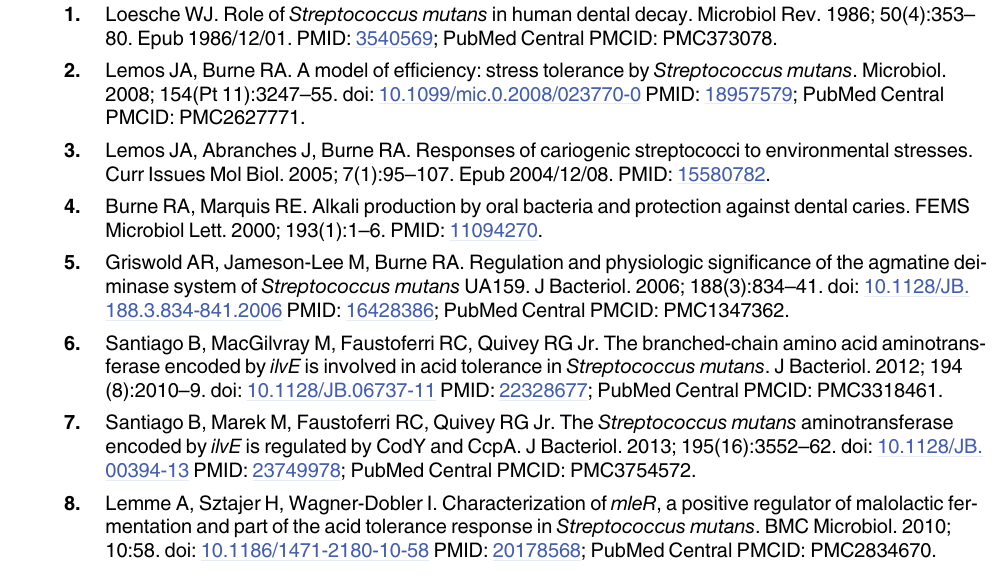
S2 Fig. The impact of growth pH and carbohydrate concentrations on the expression of the GlnR regulon genes in S . mutans GS5. Wild-type GS5 was grown in chemostat in TY contain- ing 20 mM (I) or 100 mM glucose (II) at pH 7.2 or pH 5.5. The relative quantity of mRNA of the GlnR regulon gene was measured by qPCR. The change in Δ Cq of each sample was normal- ized with 16S RNA. The Δ Cq of wild-type GS5 grown at pH 7.2 with 20 mM glucose was used as the reference. Numbers are the means and standard deviations of three independent experi- ments. The significant difference between samples under each growth condition was deter- mined by Student ’ s t test. (cid:1)(cid:1) , P < 0.001; (cid:1) , P < 0.01, #, P < 0.05. S3 Fig. The expression of dnaA , dnaE , and gyrA is not regulated by PmrA. Total cellular RNA was isolated from wild-type GS5 and strain Δ PmrA grown in chemostat in TY containing 20 mM (A) or 100 mM glucose (B) at pH 7.2 or pH 5.5. The relative quantity of mRNA of dnaA , dnaE , and gyrA was measured by qPCR. The change in Δ Cq of each sample was normal- ized with 16S RNA. The Δ Cq derived from wild-type GS5 grown at pH 7.2 was used as the ref- erence. Numbers are the mean and standard deviation of three samples. S1 Table. Primers used in this